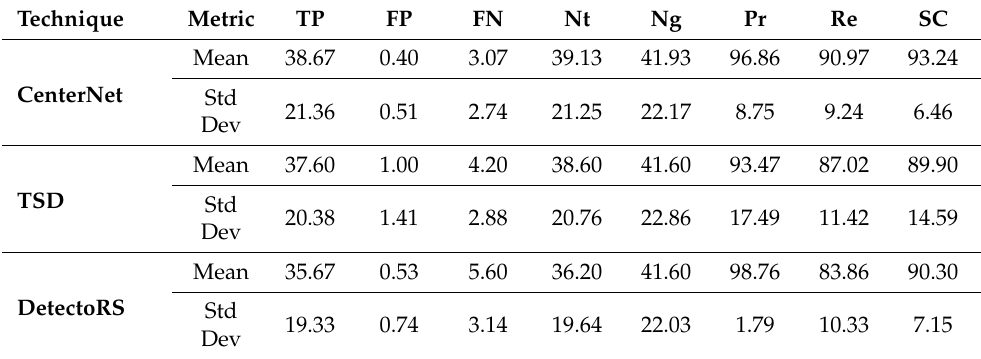
Table 3. Testing results for detection-based